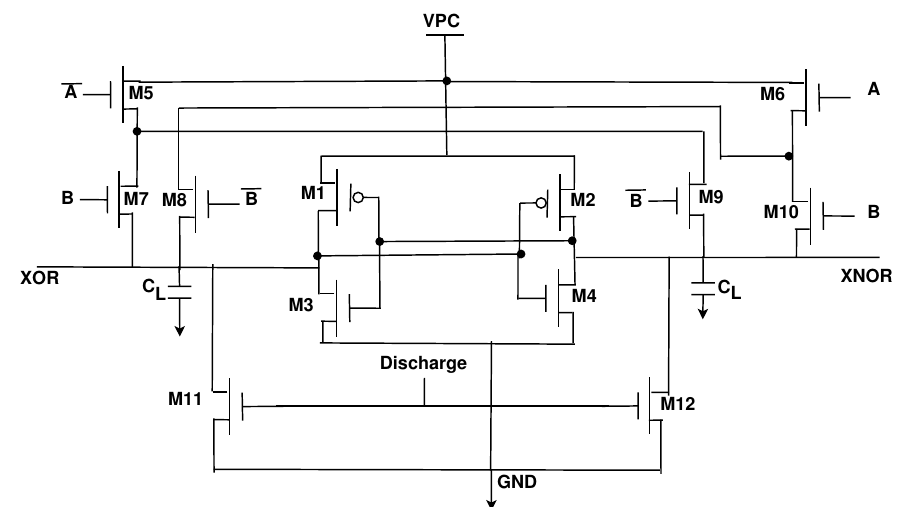
Figure 13. 2-EE-SPFAL XOR Gate used to implement the add round key stage of PRESENT [30].